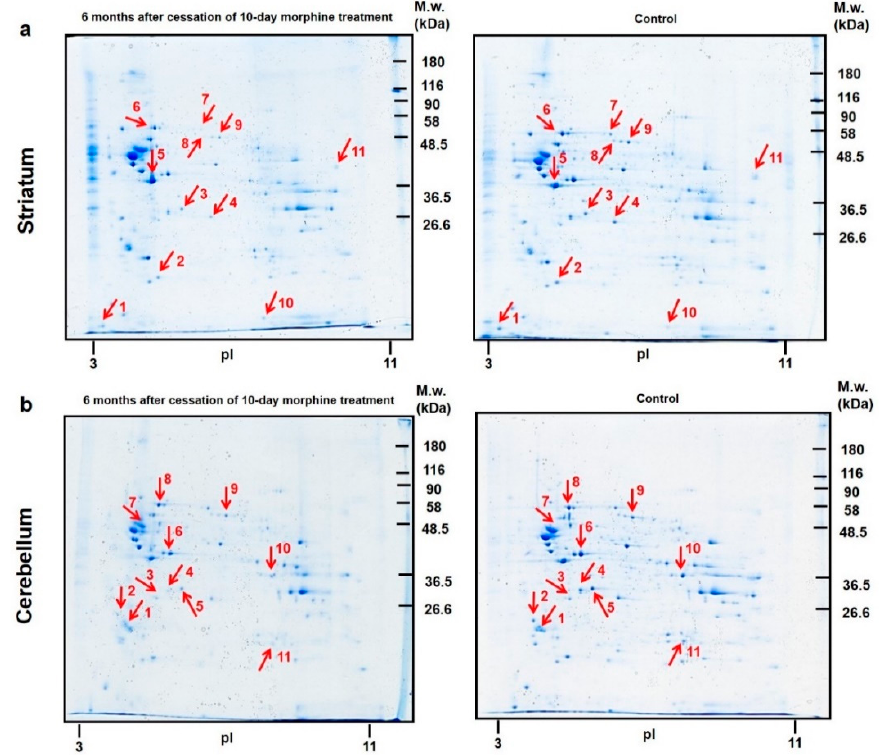
Figure 6. Representative 2D gel maps of total protein profiles in the rat striatum ( a , upper panels ) and cerebellum ( b , lower panels ) isolated from animals after 6 months of morphine withdrawal. Red arrows and numbers show the significantly altered protein spots.